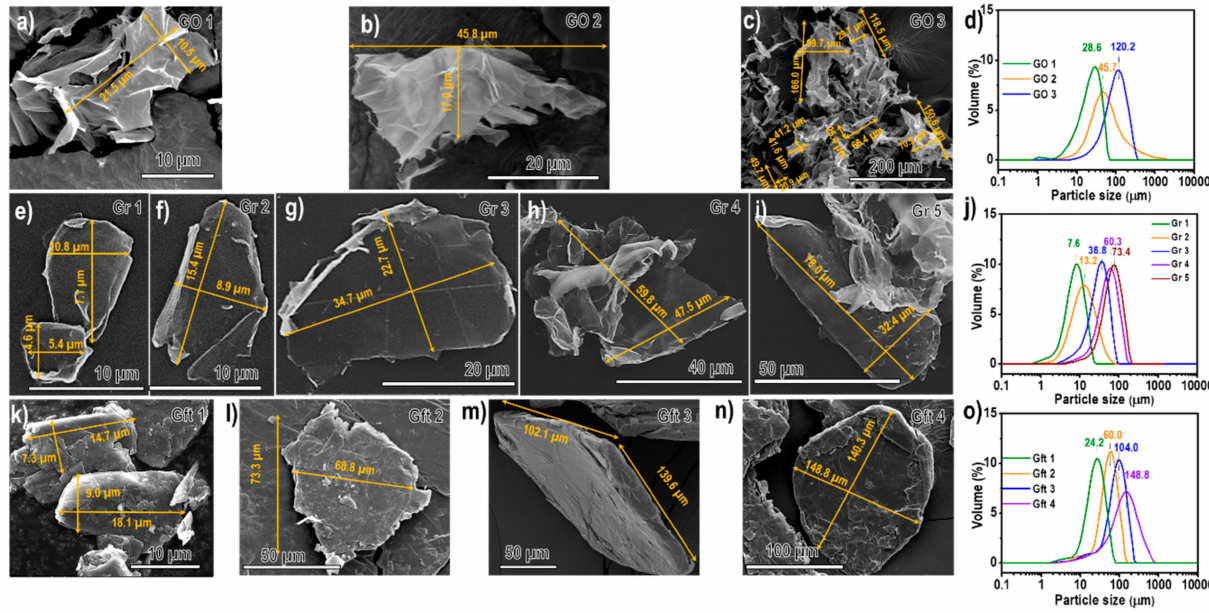
Figure 1. Representative FESEM images with PSD/LD plot of ( a – d ) GO 1–3, ( e – j ) Gr 1–5 and ( k – o ) Gft 1–4. Direct imaging technique (FESEM) was adopted to represent the size of GRM particles based on the 2D lateral dimensions as indicated by the orange solid line; Typical LD-particle size distribution (PSD/LD) plots based on median particle size by volume, d(50) v where the peak of the curve determined from their graphene, GO and graphite